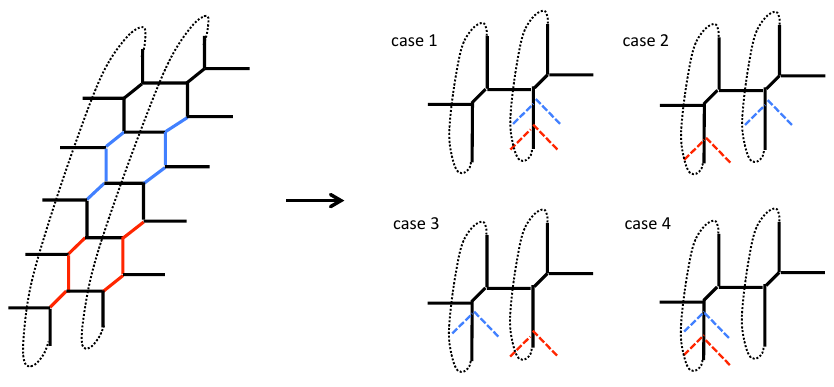
Figure 8 . In this geometric transition we obtain the T -operator which consists of two Y -operators for A 1 quiver. We set the K(cid:127)ahler parameters in the blue and red parts.